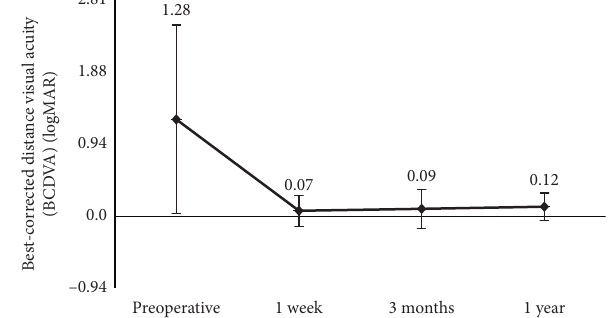
Figure 2: Preoperative and postoperative best-corrected distance visual acuity (BCDVA) ( n � 144 eyes). Table 1: Best-corrected near visual acuity (BCNVA) before and after surgery.